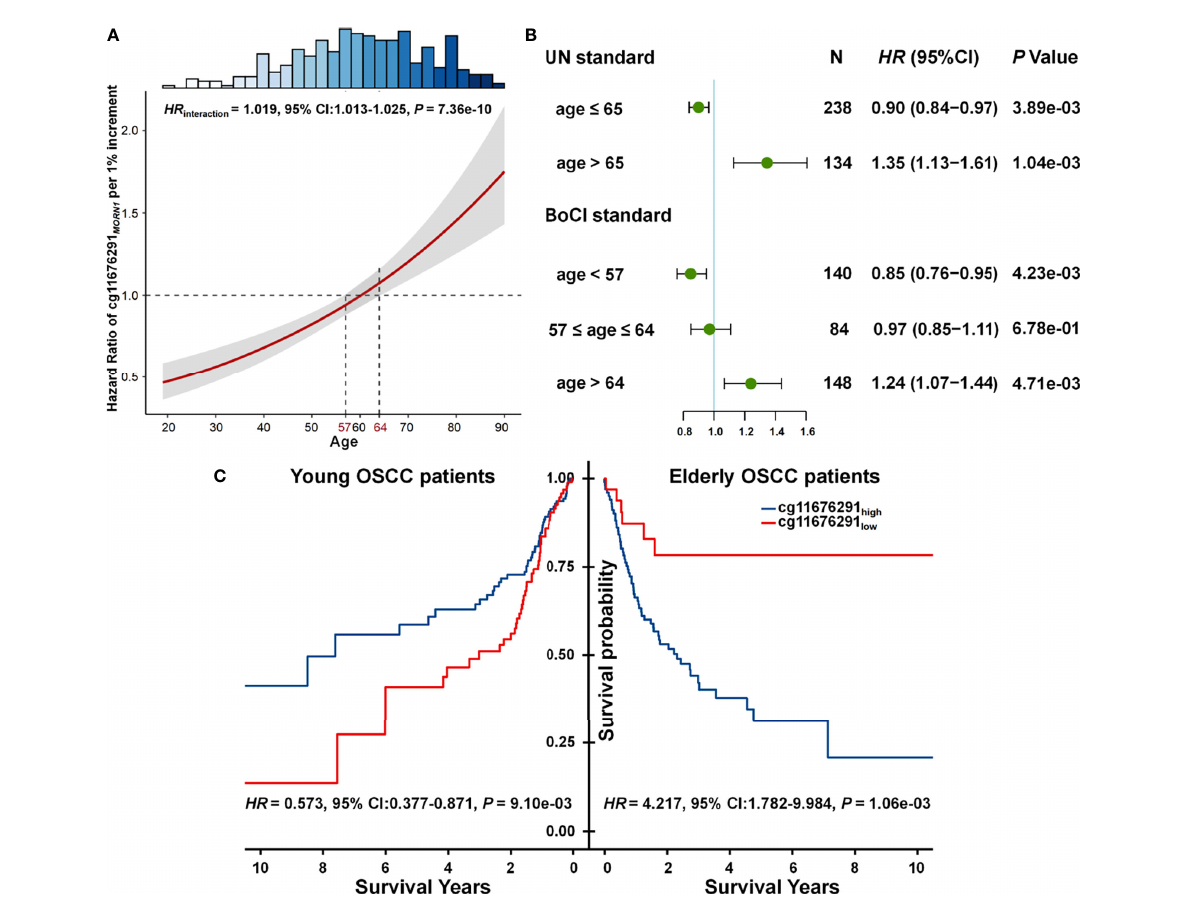
FIGURE 2 Gene – age interaction on survival of OSCC patients. (A) HR of cg11676291 MORN1 1% per increment of methylation level among differently aged patients. The 95% CI bands of HRs for patients aged <57 and >64 years were signi fi cantly different. The top histogram shows the distribution of age. (B) Forest plots of HR of cg11676291 MORN1 1% per increment of methylation level in young and elderly OSCC patients, categorized based on BoCI and UN standards. (C) Kaplan – Meier survival curves of low and high DNA methylation groups among young and elderly OSCC patients were de fi ned using the BoCI